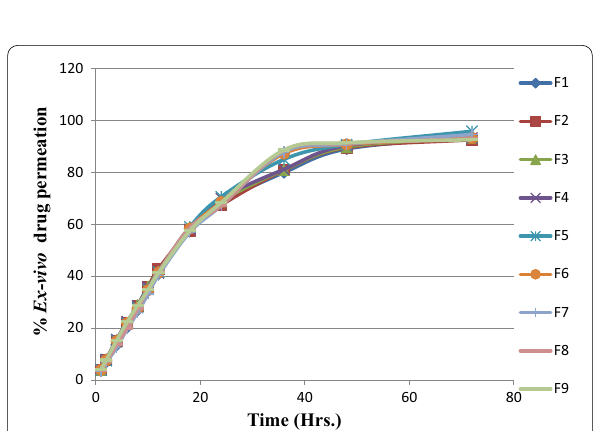
Fig. 7 Ex vivo skin drug permeation (after 72 h) of transdermal patch (F1–F9)